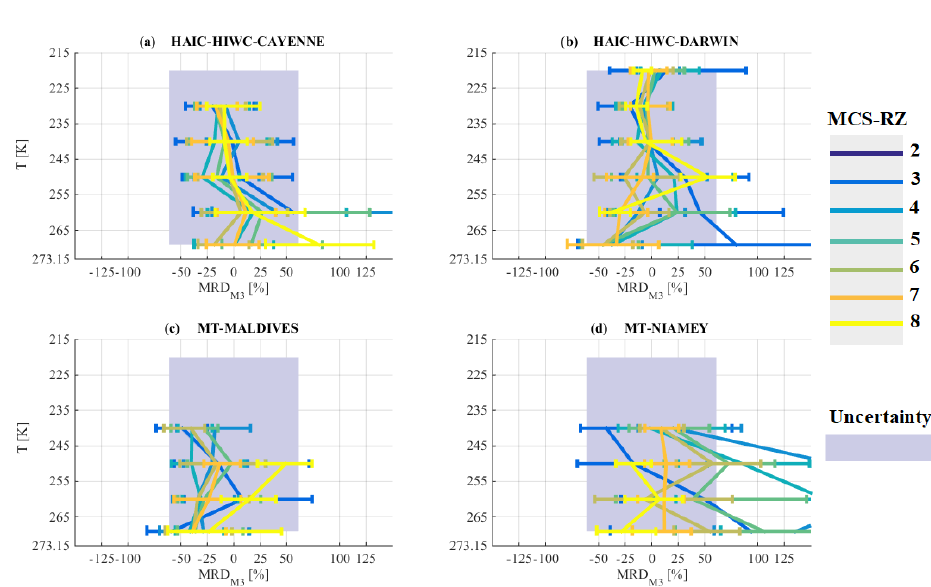
Figure 24. The same as Fig. 6 but for the M 3 .